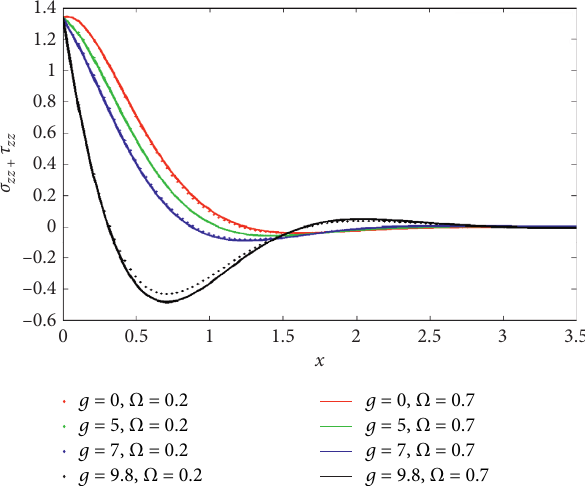
Figure 16: Stress τ